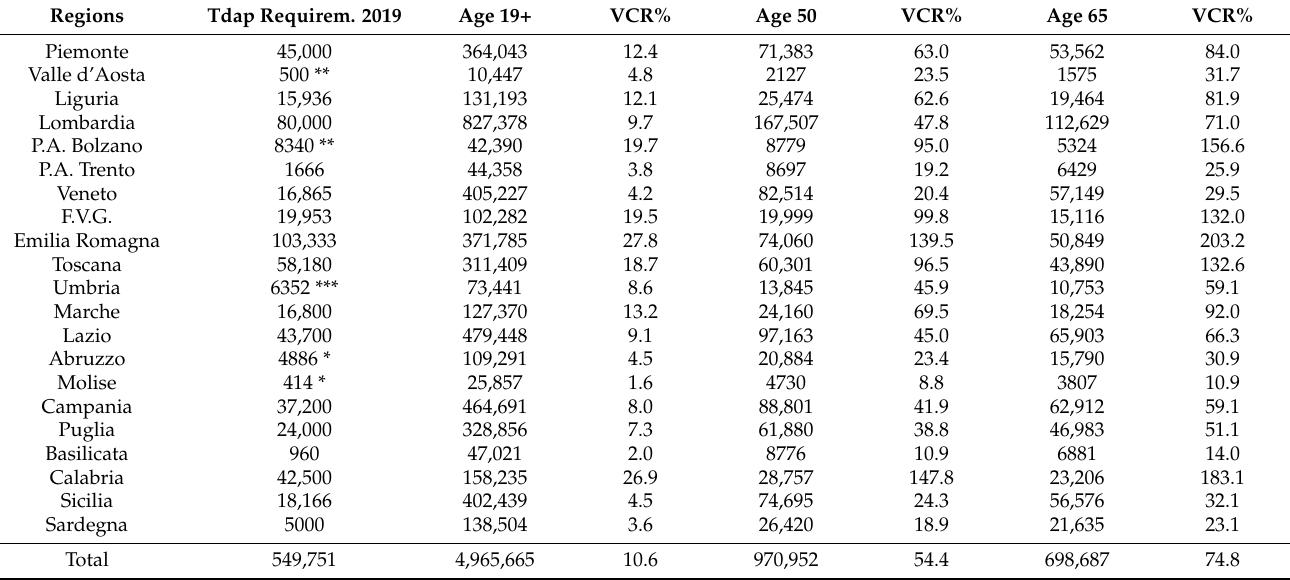
Table 1. Tdap requirements from 21 Italian Regions for year 2019, eligible populations, regional and national